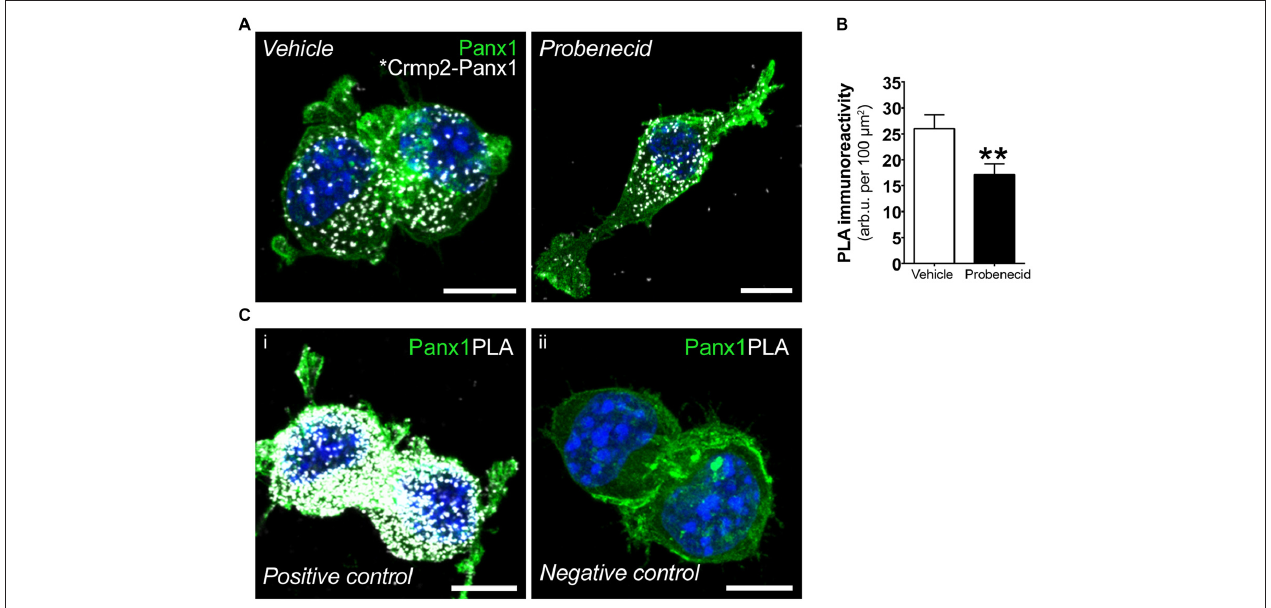
FIGURE 4 | Probenecid decreases proximity ligation assay (PLA) between Panx1EGFP and Crmp2. (A) Representative confocal maximum intensity projections of vehicle- (left) and probenecid-treated (right) Panx1-EGFP-expressing N2a cells demonstrating PLA-positive Crmp2-Panx1 clusters (white). (B) Probenecid treatment significantly decreased mean fluorescence intensity of the PLA signal (vehicle: 26.0 ± 2.7 arb.u. per 100 µ m 2 vs. probenecid: 17.1 ± 2.1 arb.u. per 100 µ m 2 , p = 0.0037, n = 77 cells and n = 70 cells, respectively, Mann-Whitney test). (C) Controls for PLA included (i) cells were incubated with α -GFP anti-mouse and α -GFP anti-rabbit to serve as a positive control. (ii) No primary antibodies were included to serve as a negative control. Hoechst 33342 was used as a nuclear counterstain. Scale bars, 10 µ m.